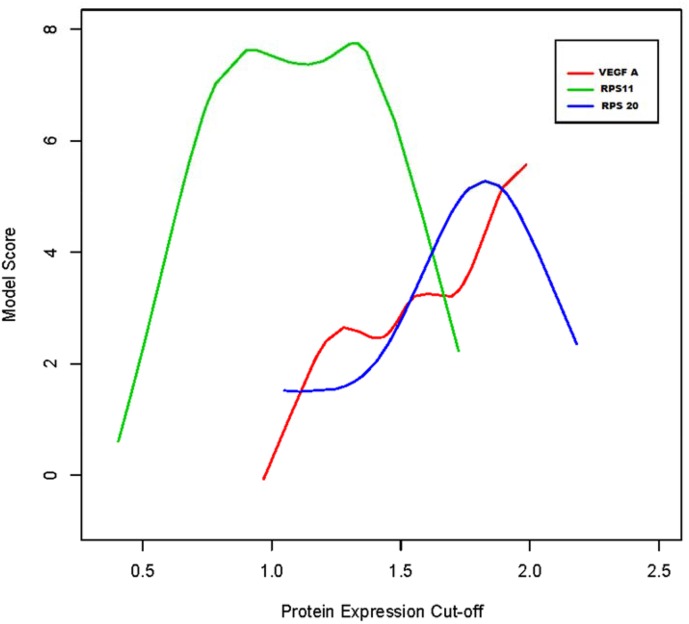
Modeling of protein expression (H-score) cutoffs for low vs. high protein expression.Each curve reports the score of a Cox Proportional Hazards model associated with different cut-off values of the related protein expression to bin scores into Low versus High expression. Protein expression is measured as the H score rescaled to (0–3). Optimal cut-offs are identified as the mode in the cut-off vs. score curve. For VEGFA, this was not identifiable and an 80th percentile H-score was used as a cut-off.